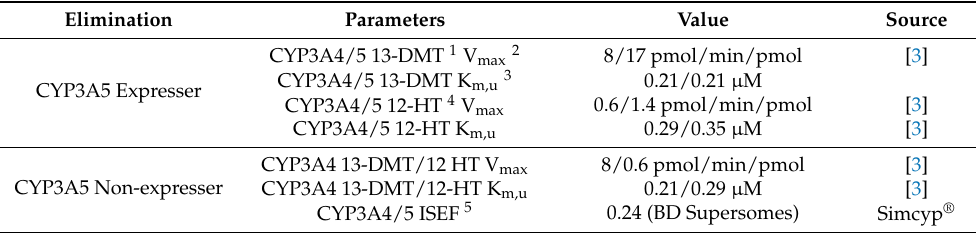
Table 3. Intrinsic clearance values for tacrolimus in each CYP isoform.